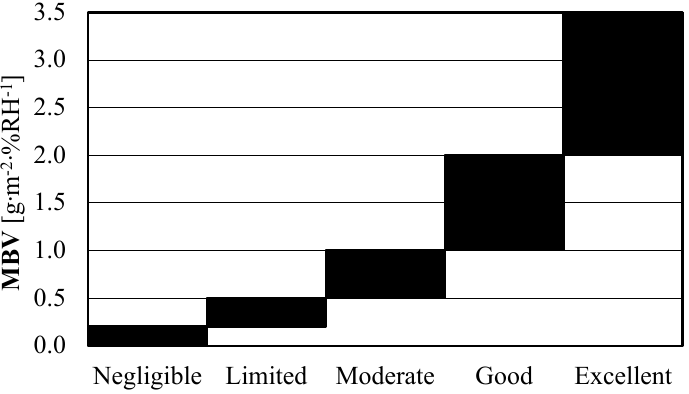
Figure 3. Ranges for practical moisture buffer value (MBVpractical) classes, adapted from [59].